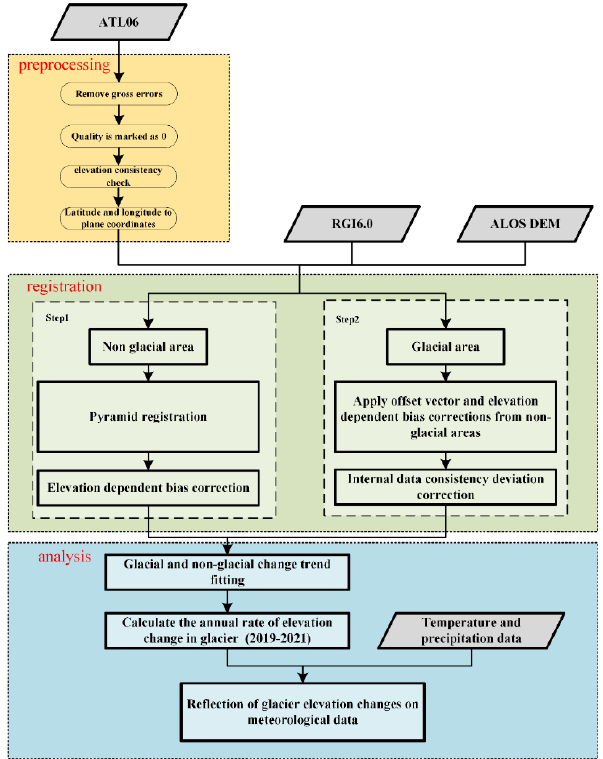
Figure 2. Technical flow